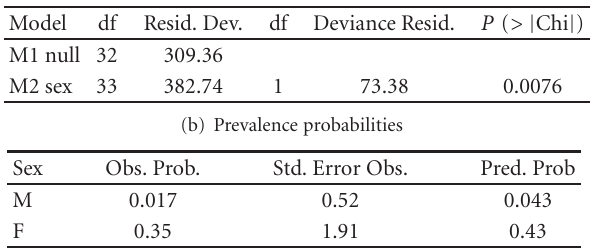
Table 3: Host sex preference of phoretic mites. (a) Analysis of Deviance table. Results of the comparison of the null model (M1) and the model with sex included (M2). (b) Observed and predicted (using Model 2) male and female infestation prevalence